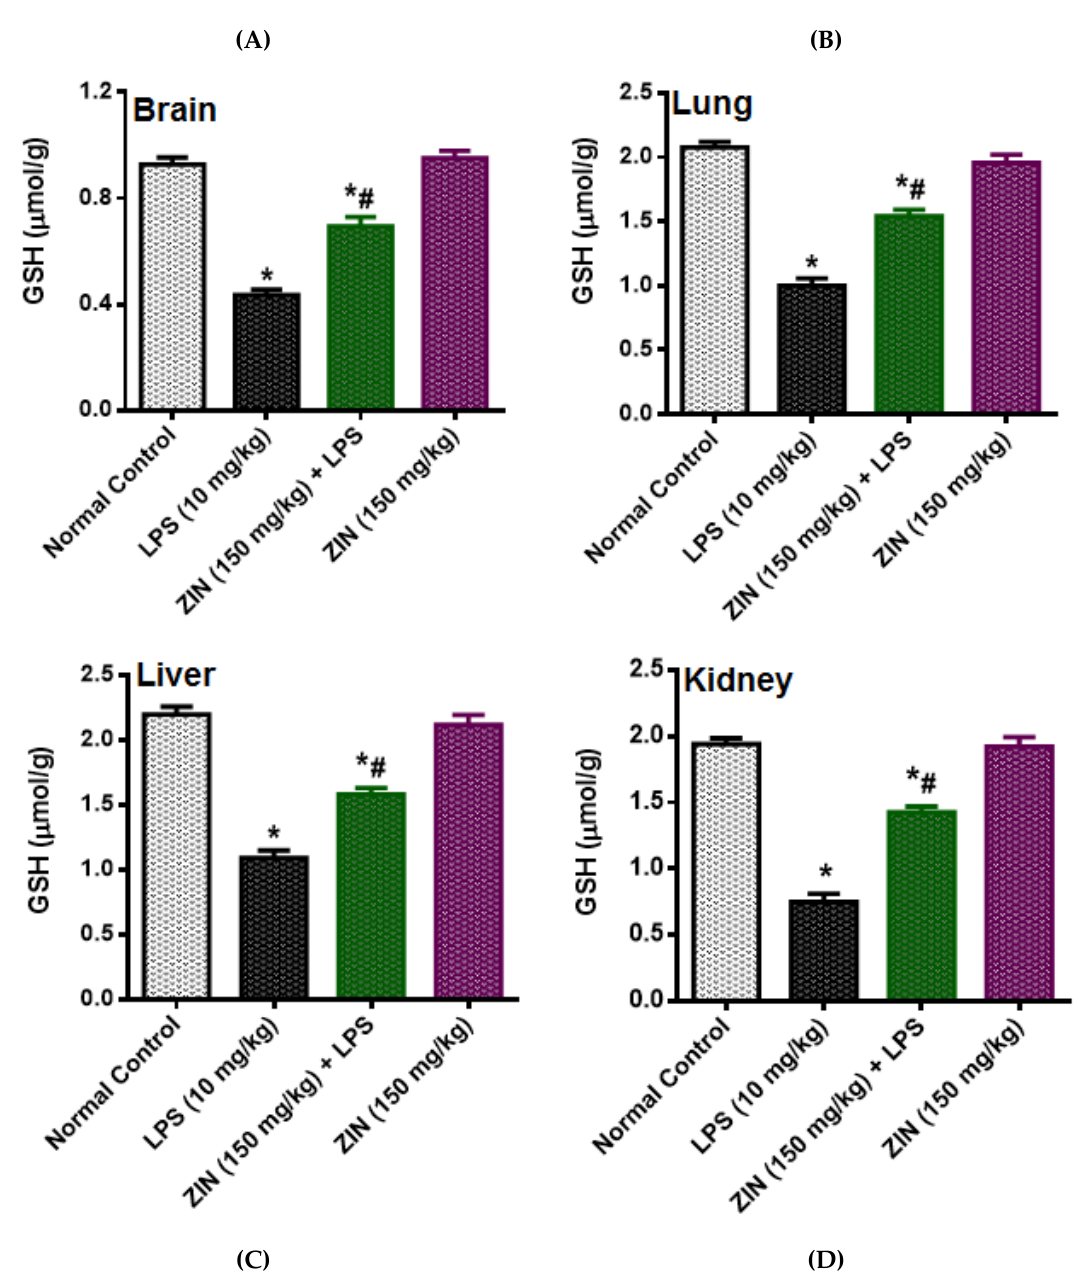
Figure 5. Effect of zingerone (ZIN) on LPS-induced oxidative stress as GSH (µmol/kg). ( A ) Brain, ( B ) Lung, ( C ) Liver and ( D ) Kidney. Results are represented as mean ± SEM of six rats/group. * p < 0.05 vs. control; # p < 0.05 vs. LPS group.